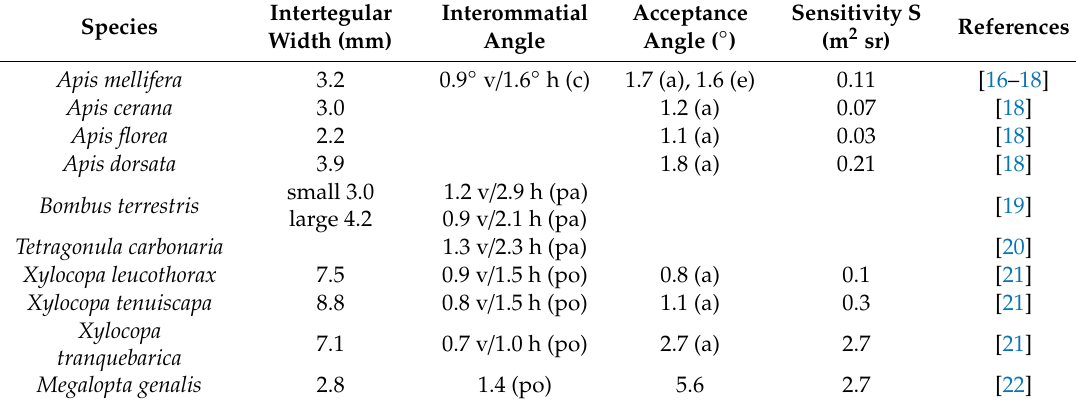
Table 1. Ommatidial values in the eye regions of highest spatial resolution and resulting optical sensitivity of female bees. (a) anatomical estimation, (e) electrophysiological measure, (c) corneal angles, (po) pseudopupil othrodromic illumination, (pa) pseudopupil antidromic illumination, (h) horizontal, (v) vertical (or close to vertical, taking average of y and z rows). For additional information and methods descriptions please see the text and